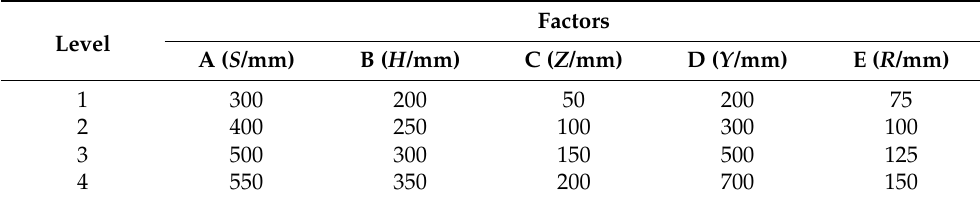
Table 2. Table of orthogonal optimization level factors.